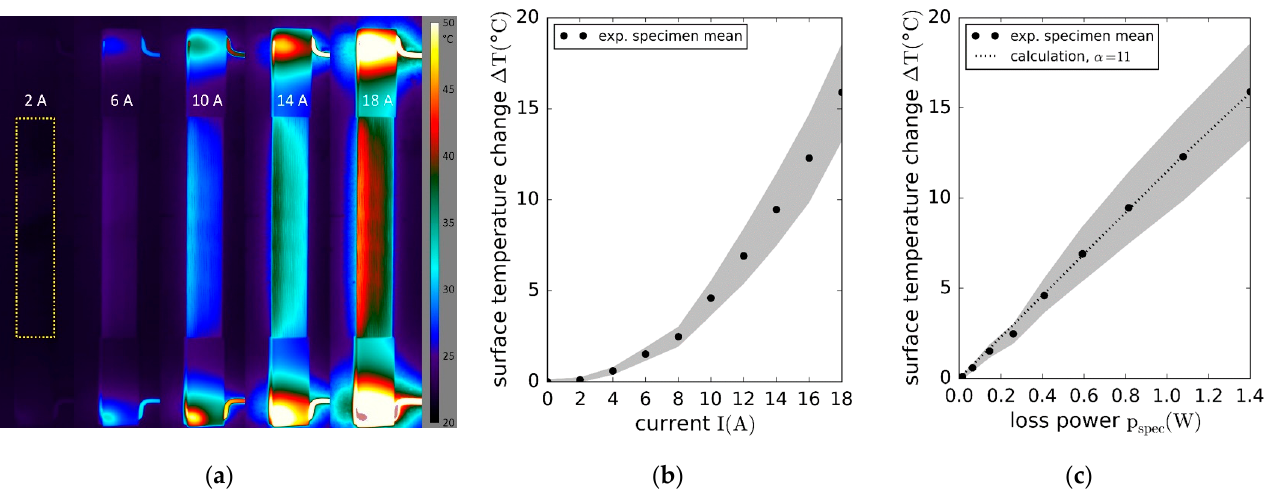
Figure 23. ( a ) Thermographic pictures of a current-carrying specimen; ( b ) measured surface relative temperature (gauge section mean temperature) plotted against the current; ( c ) measured and calculated temperature plotted against the gauge section loss power.